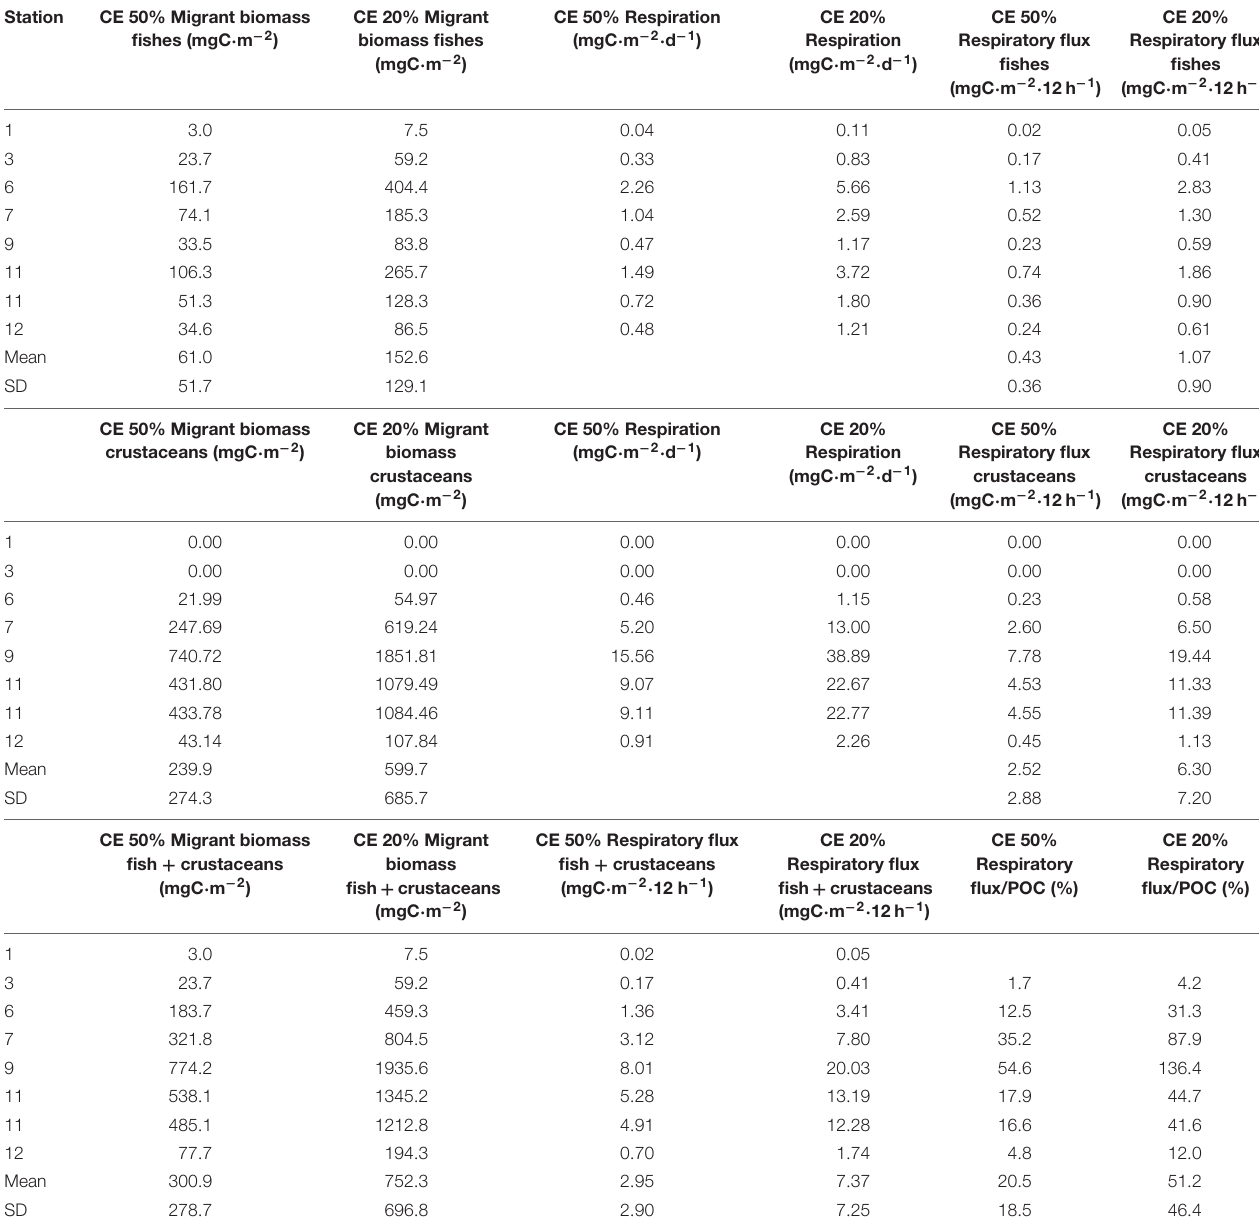
TABLE 2 | Micronekton migrant biomass using 20 and 50% of capture efficiency for the Mesopelagos trawl and respiration rates, respiratory flux obtained using both capture efficiencies along the tropical and subtropical Atlantic Ocean.